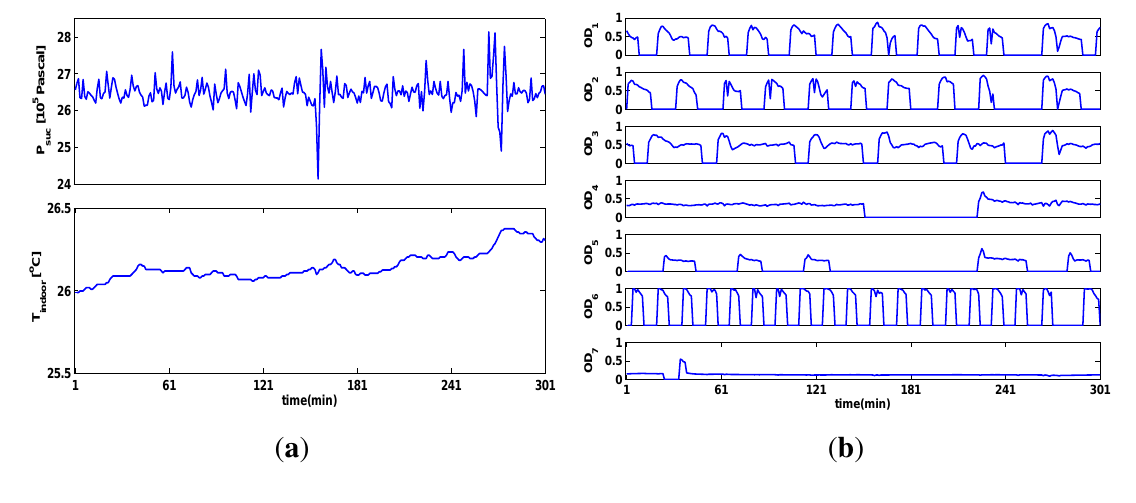
Figure 3. The input signals provided in the training set for the display case